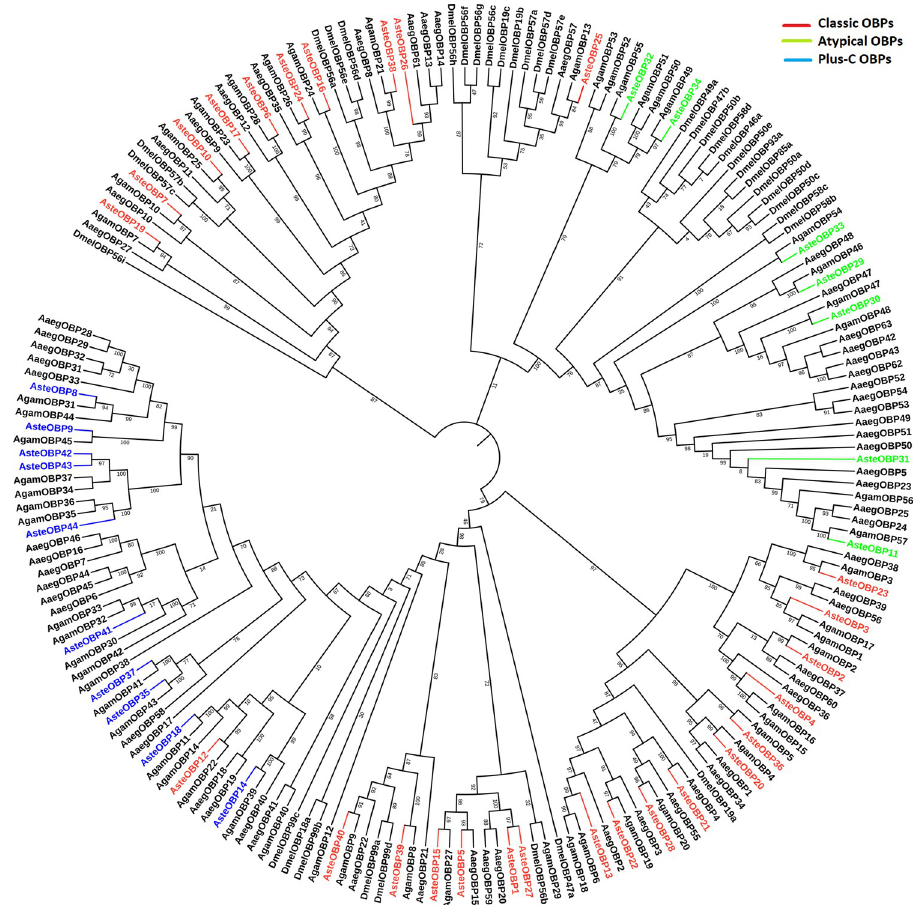
Fig 5. Phylogenetic analysis of OBPs. Phylogenetic analysis of the OBPs of Anopheles stephensi , Anopheles gambiae , Aedes aegypti and Drosophila melanogaster were carried out using FastTree 2. An . stephensi OBPs showed closer relationship to An . gambiae OBPs. The bootstrap values have been represented in the figure.